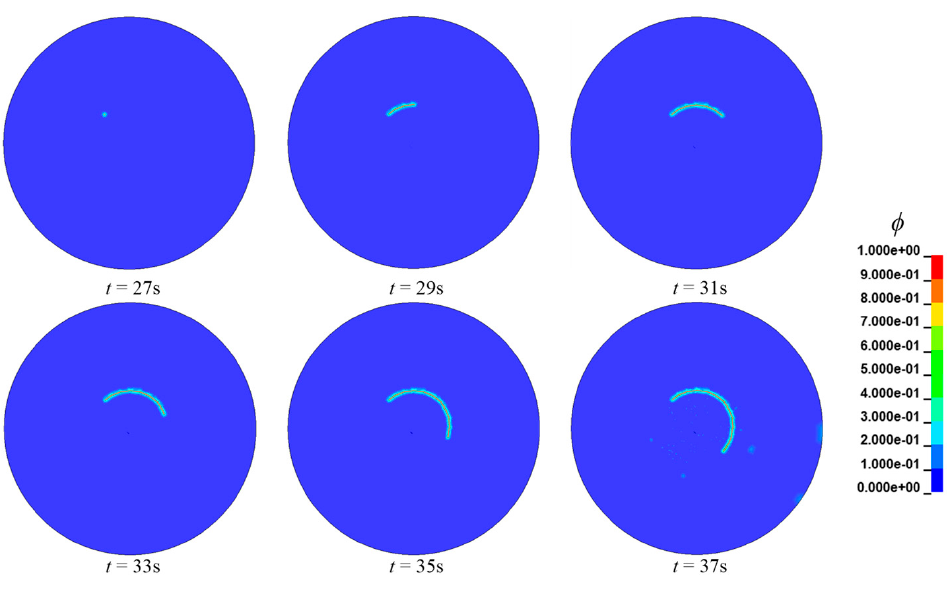
(b) Mesh Unit :mm Figure 18. Model and mesh in Case 4. We numerically calculated the fracture process of high chromium alloy MANETA under the conditions of C 0 = 0, 1.5, 1.9, 2.5, 3.0, and 3.5 ppm. Moreover, we extracted the Mises stress at the crack tip when failure, denote by 𝜎 . The comparison between the cal- culated results and test results is shown in Table 3. Table 3. Comparison between simulation and test for Case 4. C 0 (ppm)